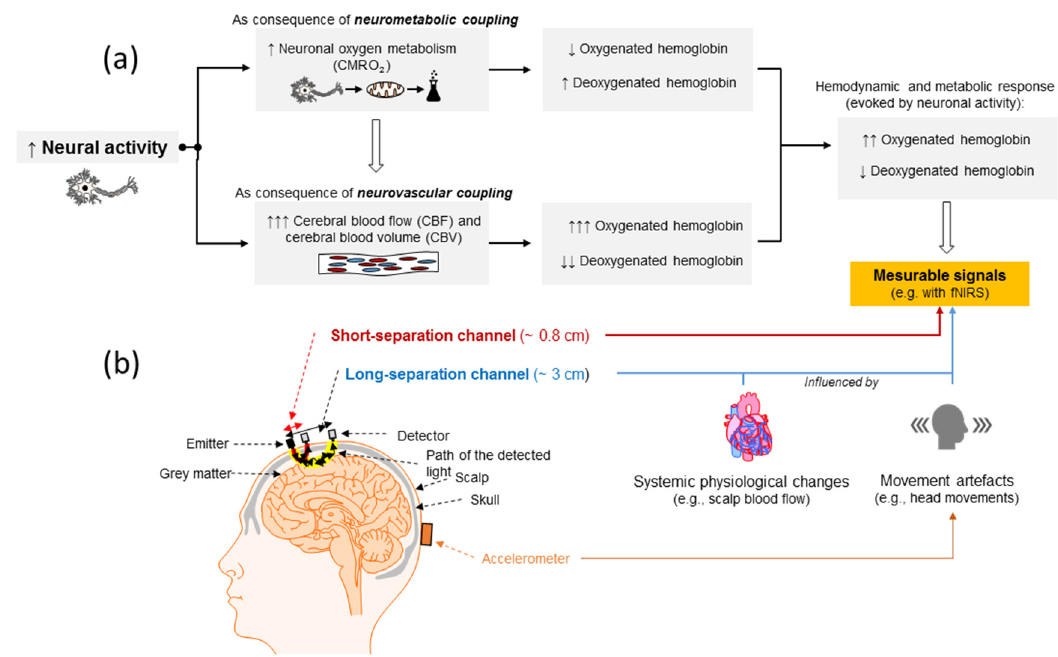
Figure 1. Schematic illustrations of ( a ) changes in cerebral hemodynamics and oxygen, induced by neural activity. ( b ) Depiction of a possible NIRS montage on the human head showing the assumed banana-shaped course of detected light of “short separation channels” and of “long separation channels”; fNIRS, functional near-infrared spectroscopy; CMRO 2 , cerebral metabolic rate of oxygen; ↑ , increase; ↓ , decrease.